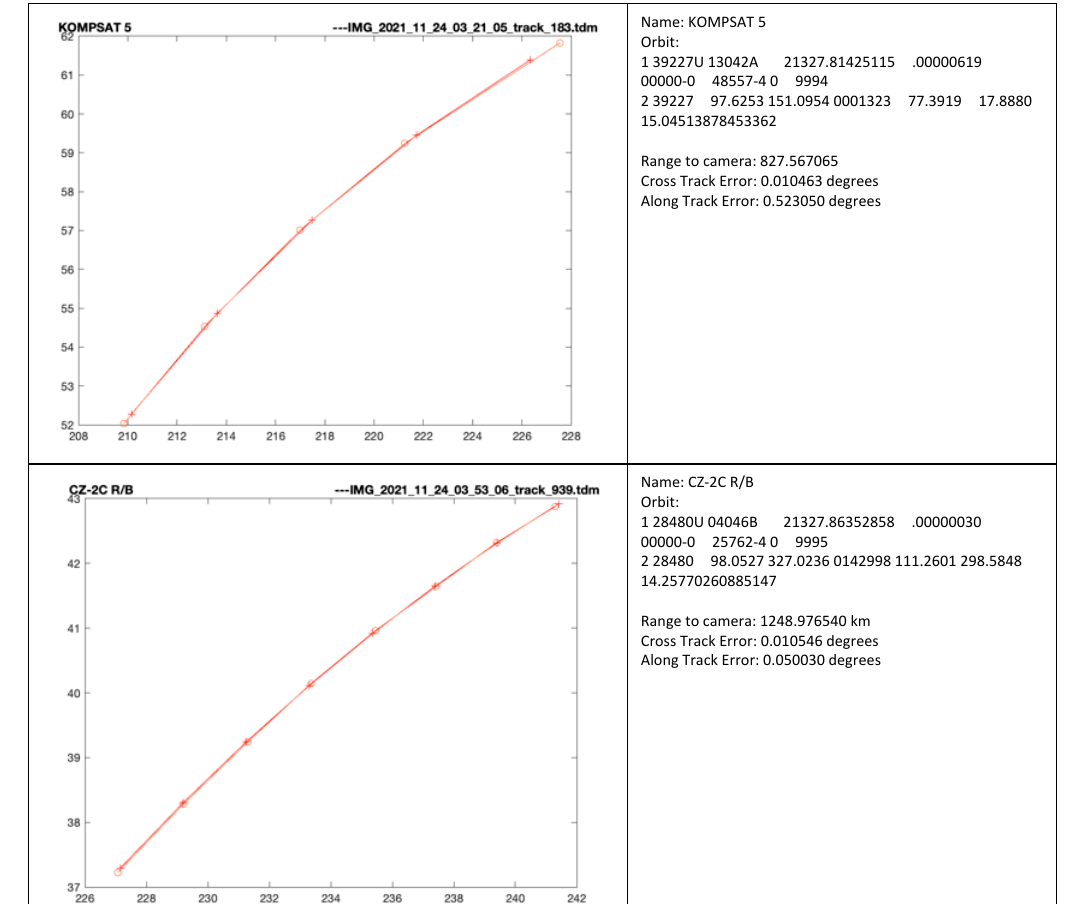
Figure 23. Selection of detected satellites (East sequence). In the left column we can see the trajectory comparison between the prediction (marked with X) and the measurement (marked with O), and in the right column we see the satellite name, the orbital parameters, and the errors.